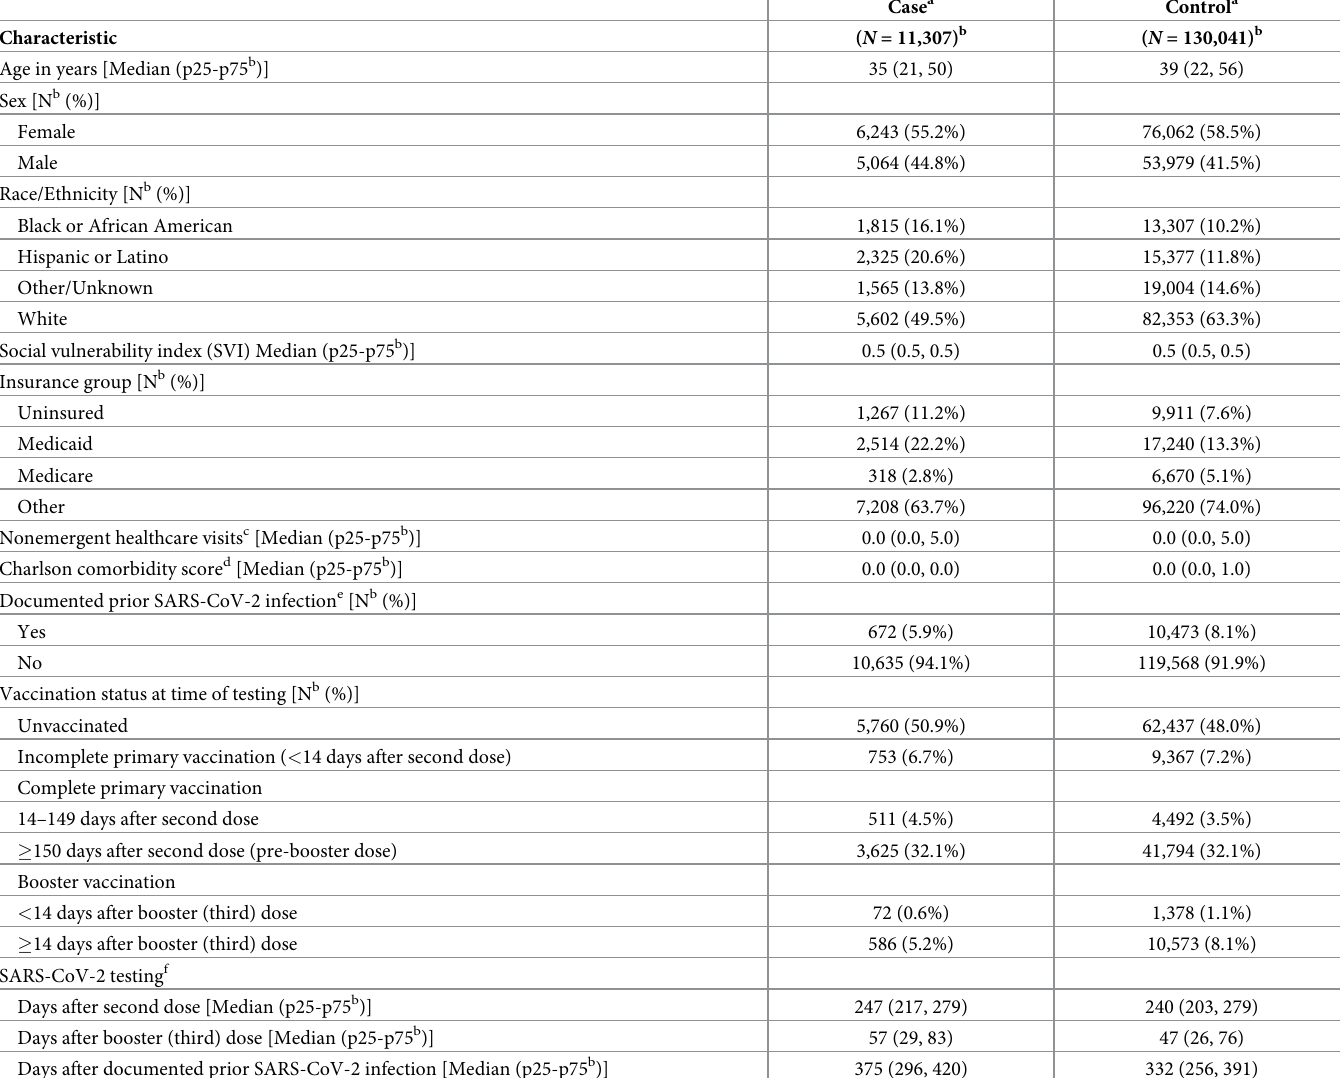
Table 1. Characteristics of SARS-CoV-2 tests included as cases or controls between November 1, 2021 and April 30,